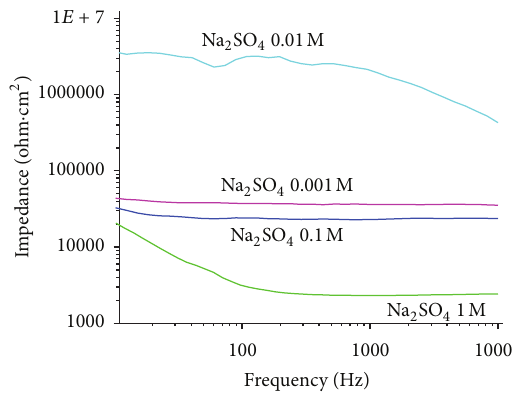
Figure 12: Electrochemical evaluation of the system Ny/FGO at 2% GO with the impedance as a function of Na 2 SO 4 solution concen-